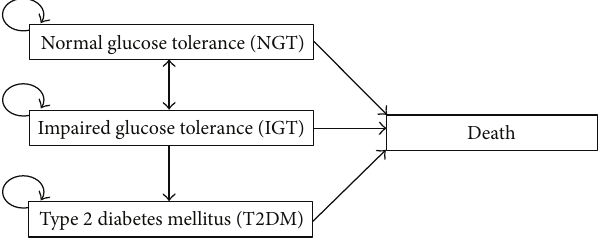
Figure 1: Annual transition diagram of Markov